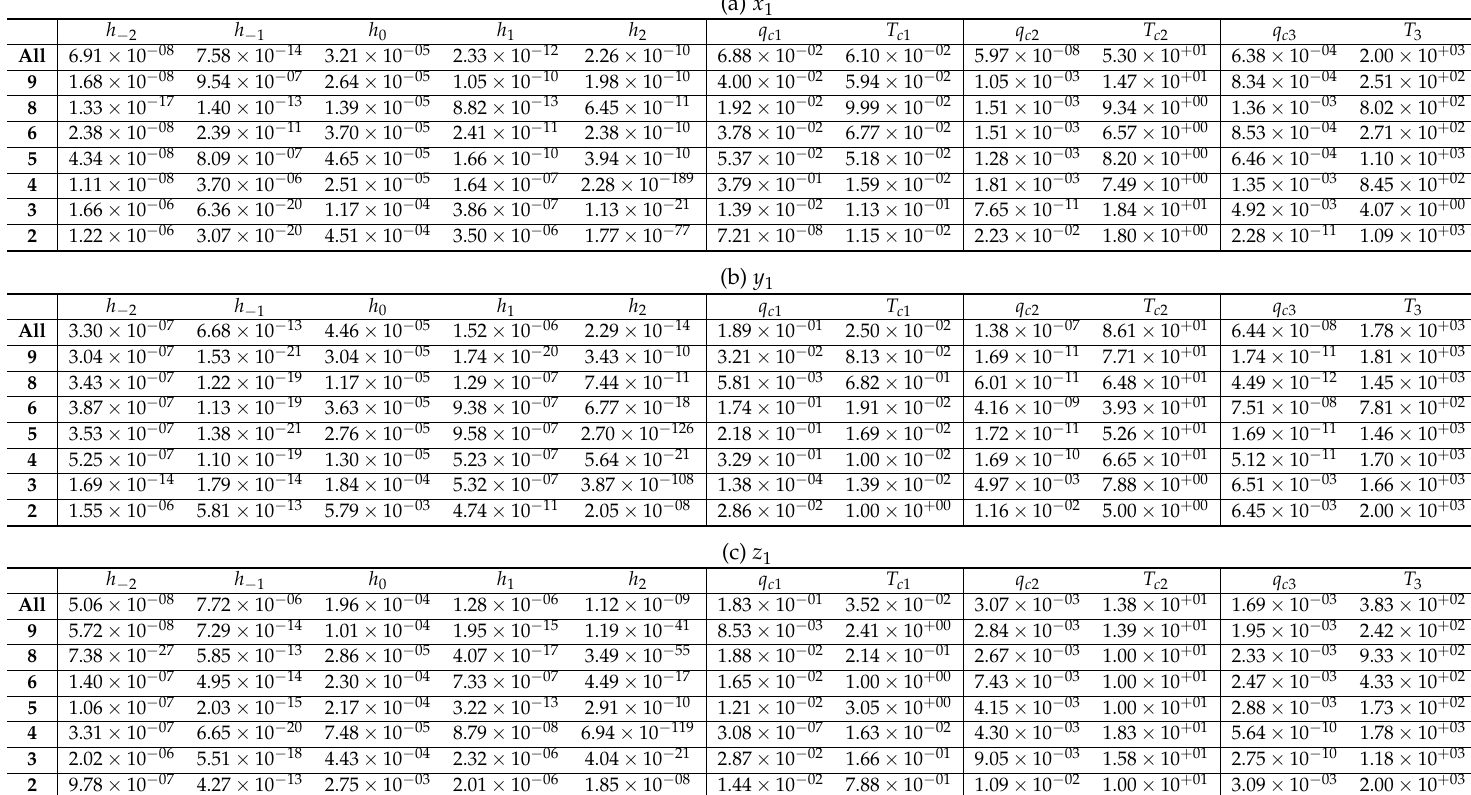
Table A3. Estimated noise parameters of Vantage cameras type for 2..9